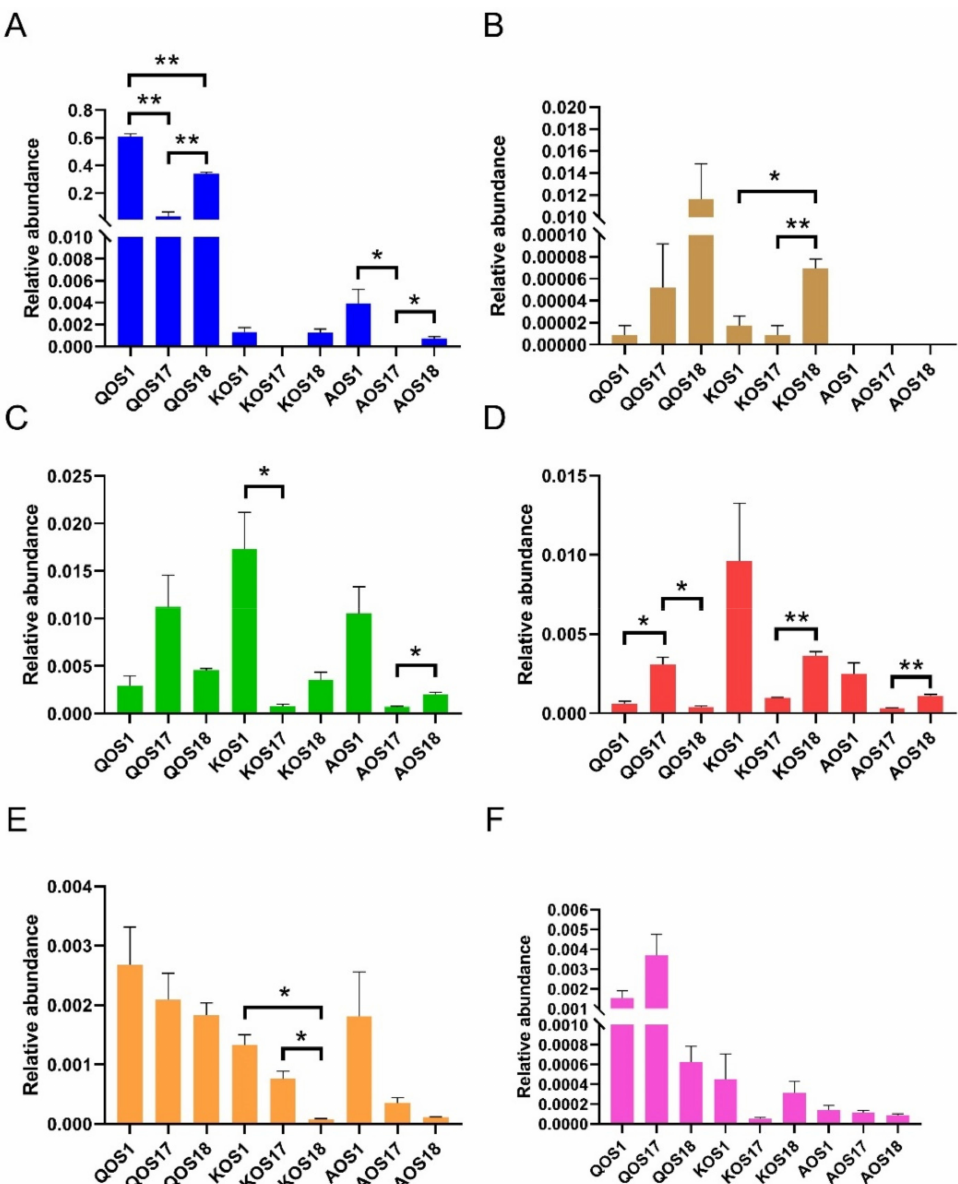
Figure 6. Comparison of the prebiotic effects of QOS, KOS, and AOS on the human gut micro- biota. Relative abundances of Bifidobacterium spp. ( A ), Lactobacillus spp. ( B ), Faecalibacterium spp. ( C ), Butyricicoccus spp. ( D ), Roseburia spp. ( E ), and Eubacterium hallii ( F ). QOS1 denotes fermentation of QOS by gut microbiota F1. QOS17 denotes fermentation of QOS by gut microbiota F17. QOS18 denotes fermentation of QOS by gut microbiota F18. Each fermentation group has three replicates. KOS and AOS were labeled using the same format. Data are expressed as mean ± SEM. Statistical analysis was performed using ANOVA with post hoc Tukey’s multiple comparisons test. * p < 0.05, ** p <